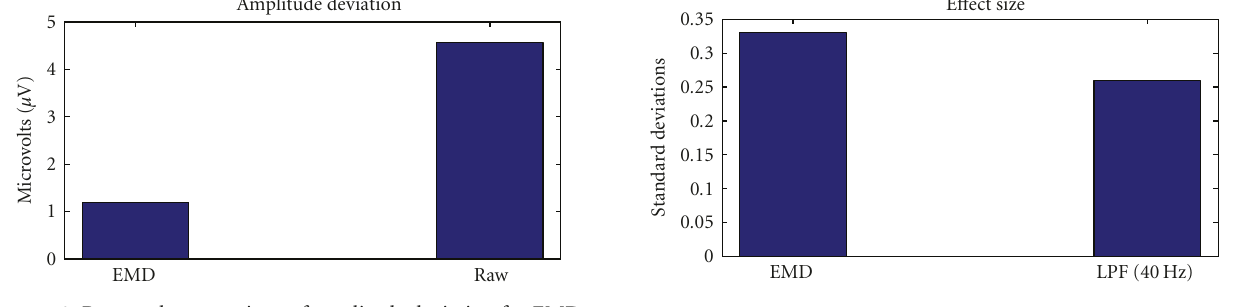
Figure 10: Bar graph comparison of e ff ect size for EMD-based and trials lowpass filtered at 40Hz. Higher E ff ect size indicates better performance.